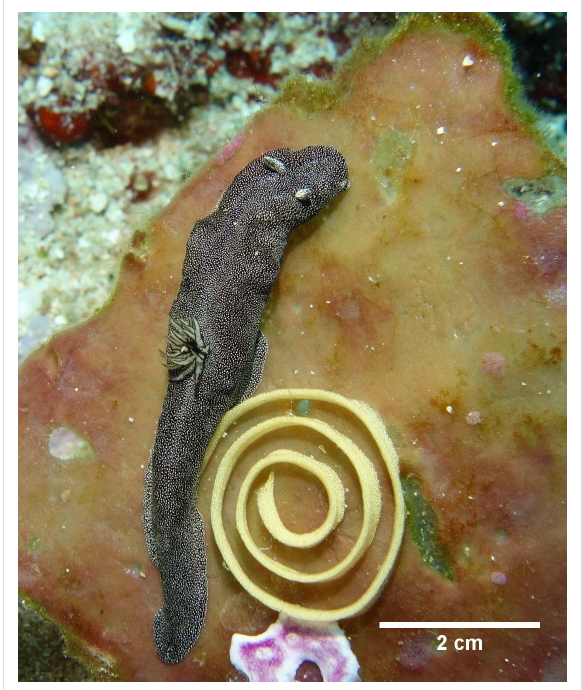
Figure 1: Doriprismatica stellata nudibranch, egg ribbon, and Spongia cf. agaricina specimen.